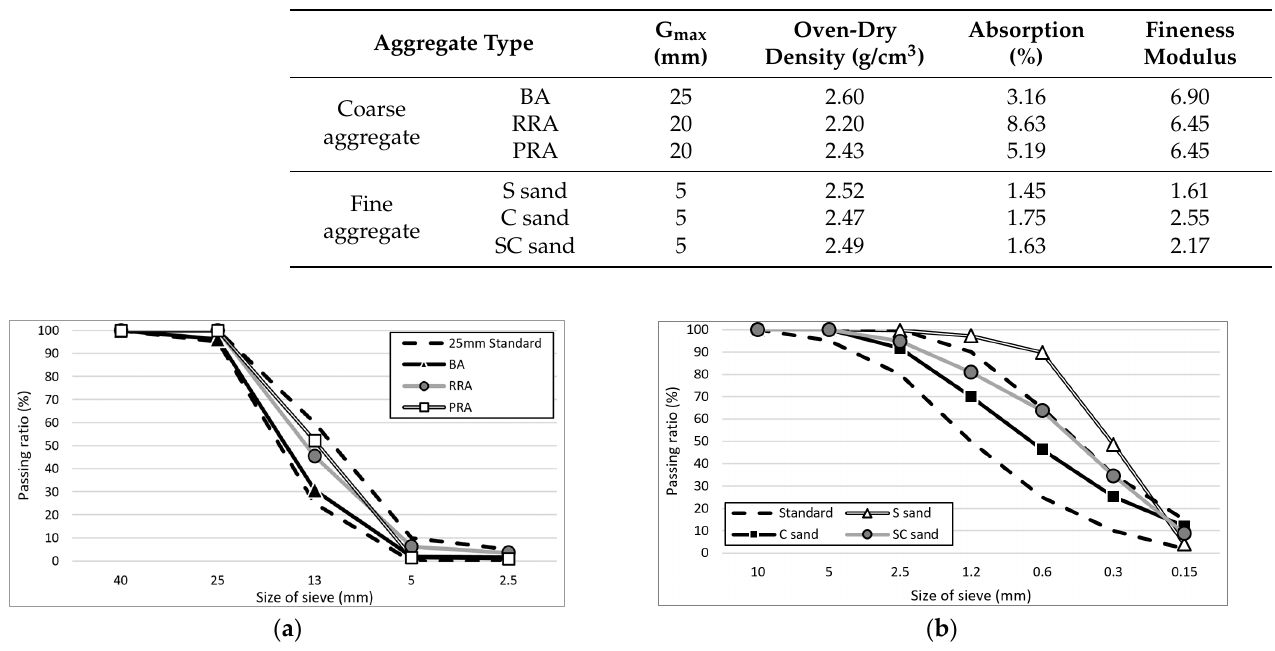
Table 5. Physical properties of the aggregate.